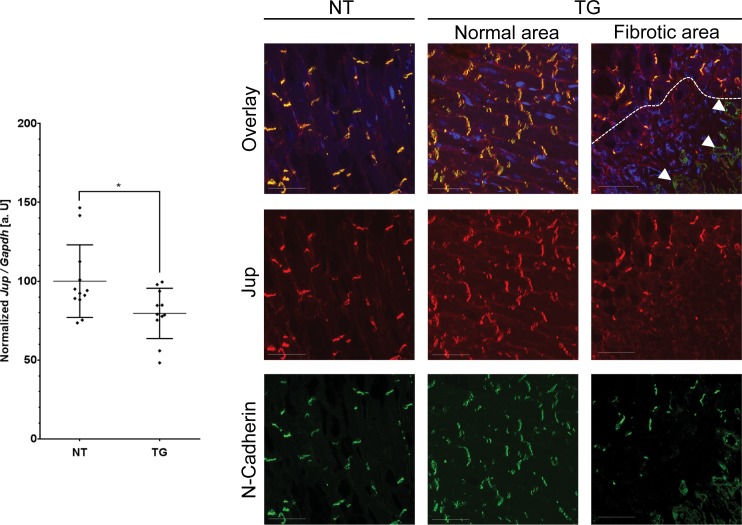
Structural and expression analysis of Jup using quantitative real-time polymerase chain reaction and immunohistochemistry.Expression analysis demonstrate a moderate but significant down-regulation mRNA of Jup (13 w; 12 NT; 11 TG). Statistical analysis was performed by non-parametric Kruskal-Wallis test (*p<0.05). Immunohistochemistry analysis of Jup (red) and N-cadherin (green) demonstrates the absence of Jup at the intercalated disc in fibrotic areas. The dashed line indicate the border between the fibrotic and normal areas. Of note, the cells within the fibrotic lesion are positive for N-Cadherin but negative for Jup (white arrows). The nuclei were stained with 4′,6-Diamidin-2-phenylindol (DAPI, blue). Scale bars represent 20 μm.